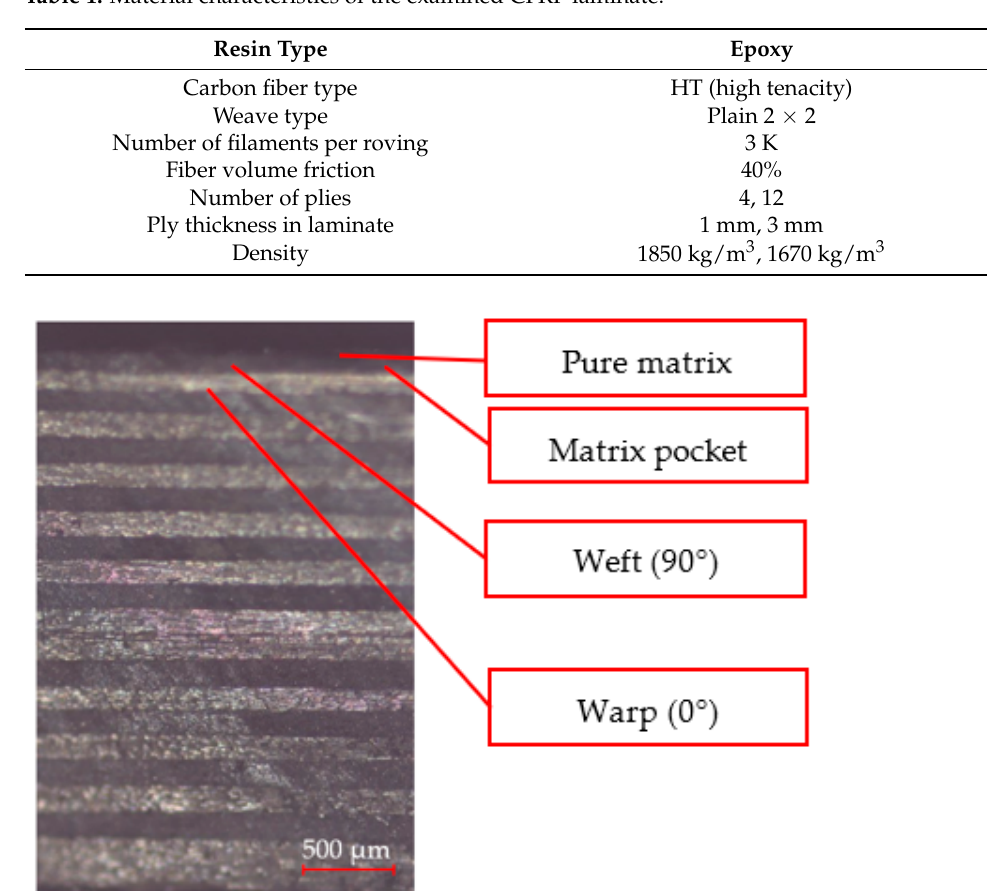
Figure 1. Cut through 3 mm thick laminate.